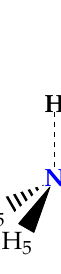
Figure 1. Sketch of